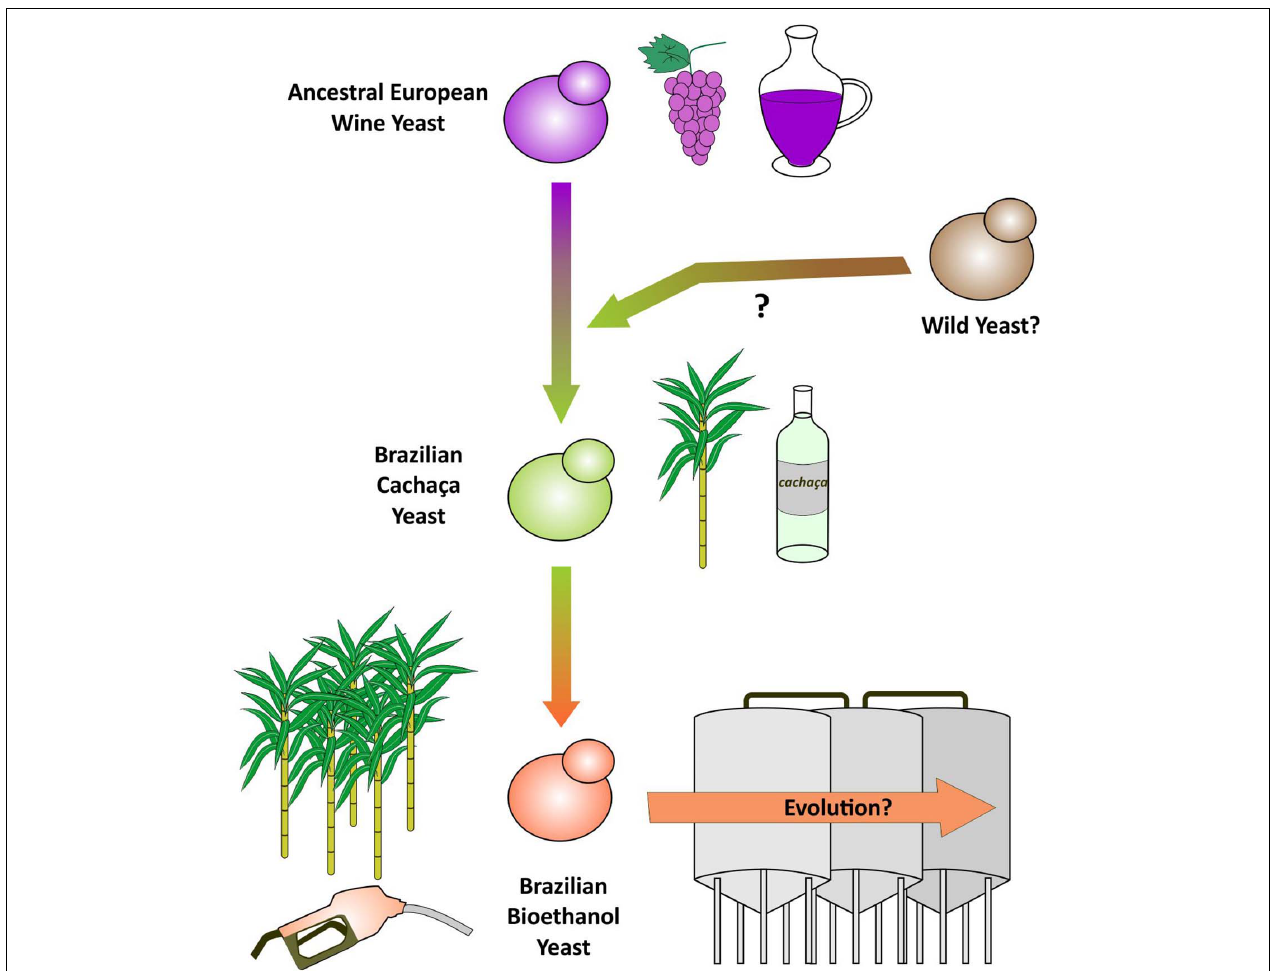
FIGURE 7 | Model for the evolution of Brazilian bioethanol yeasts. Cachaça yeasts probably derive from an ancestral European yeast lineage domesticated for the wine-making process. Since cachaça and bioethanol yeasts have a mosaic genome structure, it is likely that at some point a hybridization event occurred between an European ancestor and a yet-unknown yeast (perhaps from a South American wild population?). Cachaça yeasts were latter co-opted for biofuel production becoming the modern-day bioethanol yeasts. The degree in which bioethanol yeasts may evolve within the process of fermentation is still unknown. This process-related evolution may account for the genetic divergence between cachaça and fuel ethanol strains.